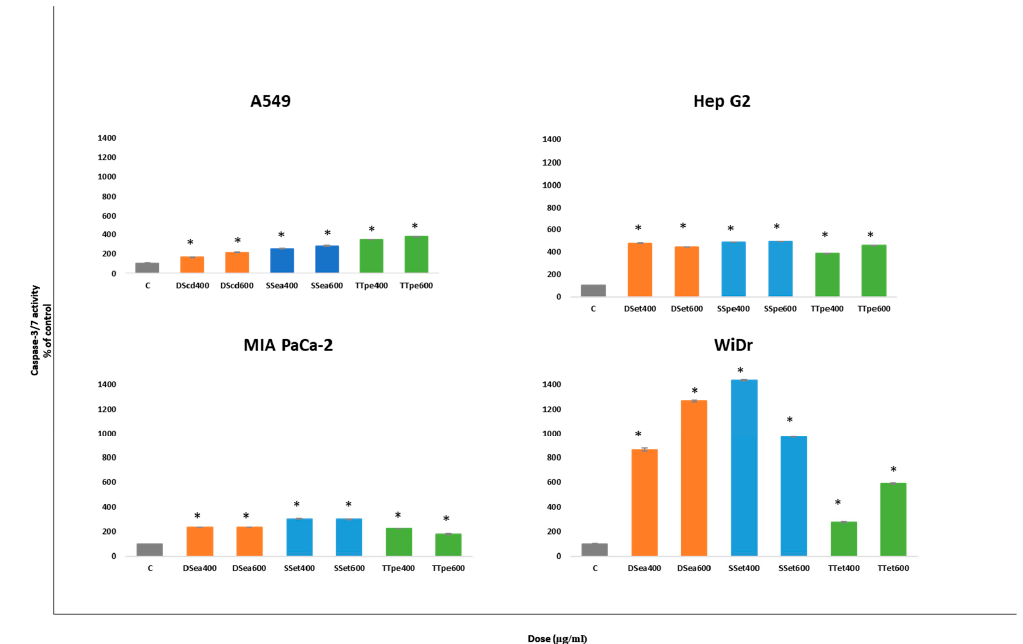
Figure 4. Caspase 3/7 activities in A549, Hep G2, MIA PaCa-2, and WiDr cells after treatment with NZ surf clam extracts. Cell lines were treated with two concentrations (400 and 600 µg for 24 h. Caspase